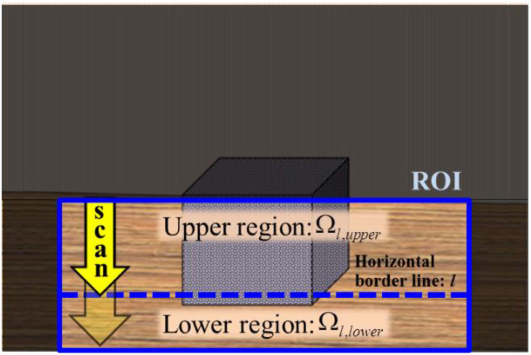
Figure 6. Formulation of problem for finding the horizontal border line that maximizes the difference in appearance between the upper and lower regions.